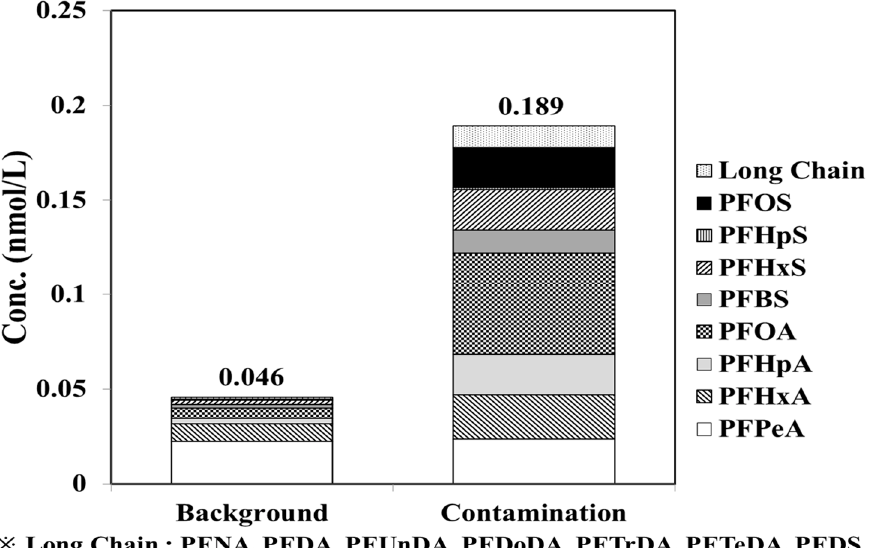
Figure 3. Mass-based average concentration by each of the PFASs.